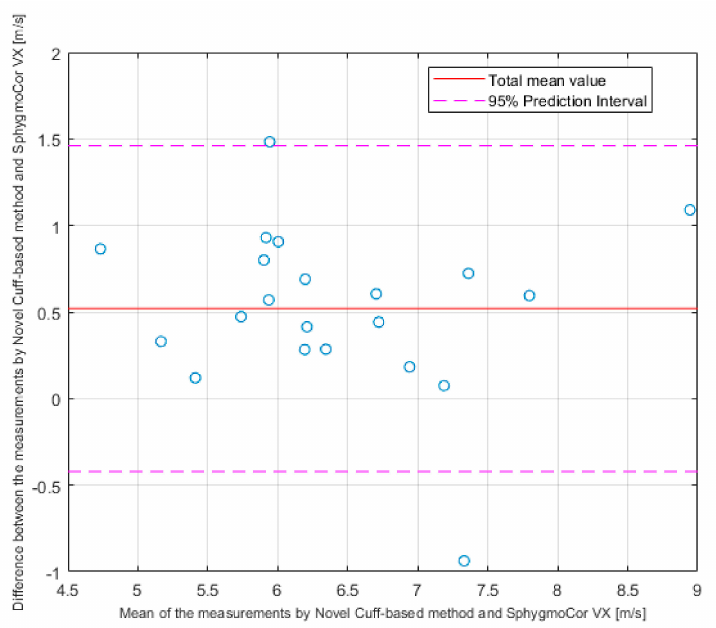
Figure 4. Bland-Altman